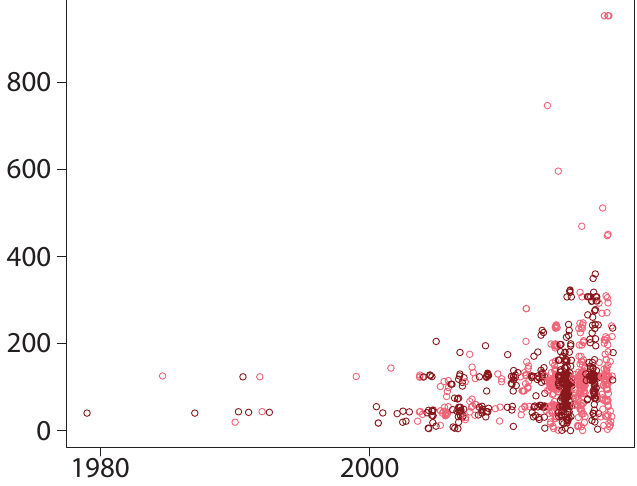
Figure 4. Northward distance (km) of recent records of Steatoda nobilis in Great Britain. Distances are calculated relative to the first known record in the country in Torquay, based on data in the SRS database and in Snazell and Jones (1993). Data from consecutive years are alternatingly coloured dark and light red.